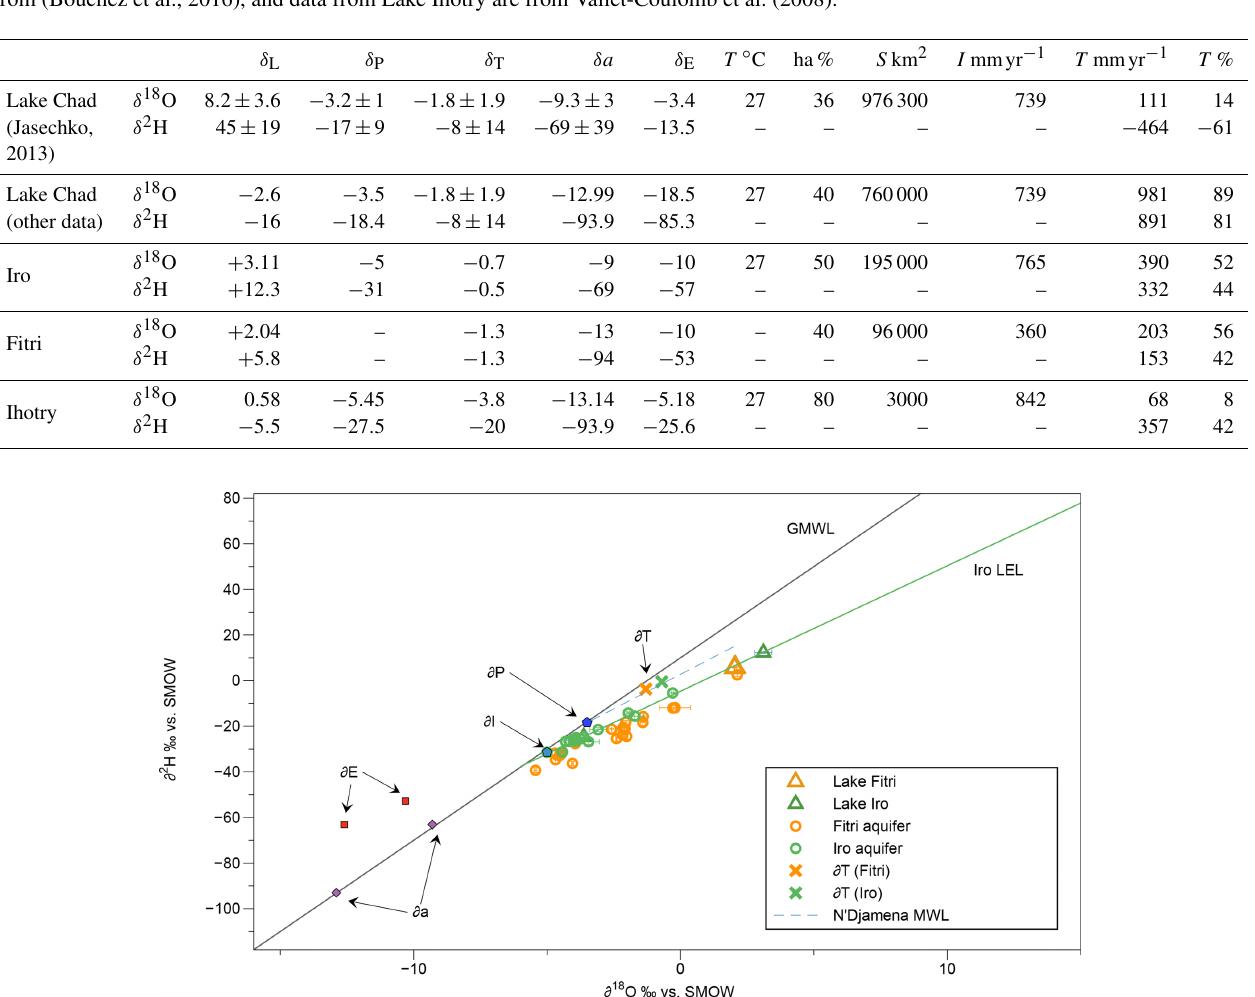
Table 2. Values used for the calculation of transpiration according to Eq. (11) for the three lakes studied. Other data from Lake Chad come from (Bouchez et al., 2016), and data from Lake Ihotry are from Vallet-Coulomb et al. (2008).